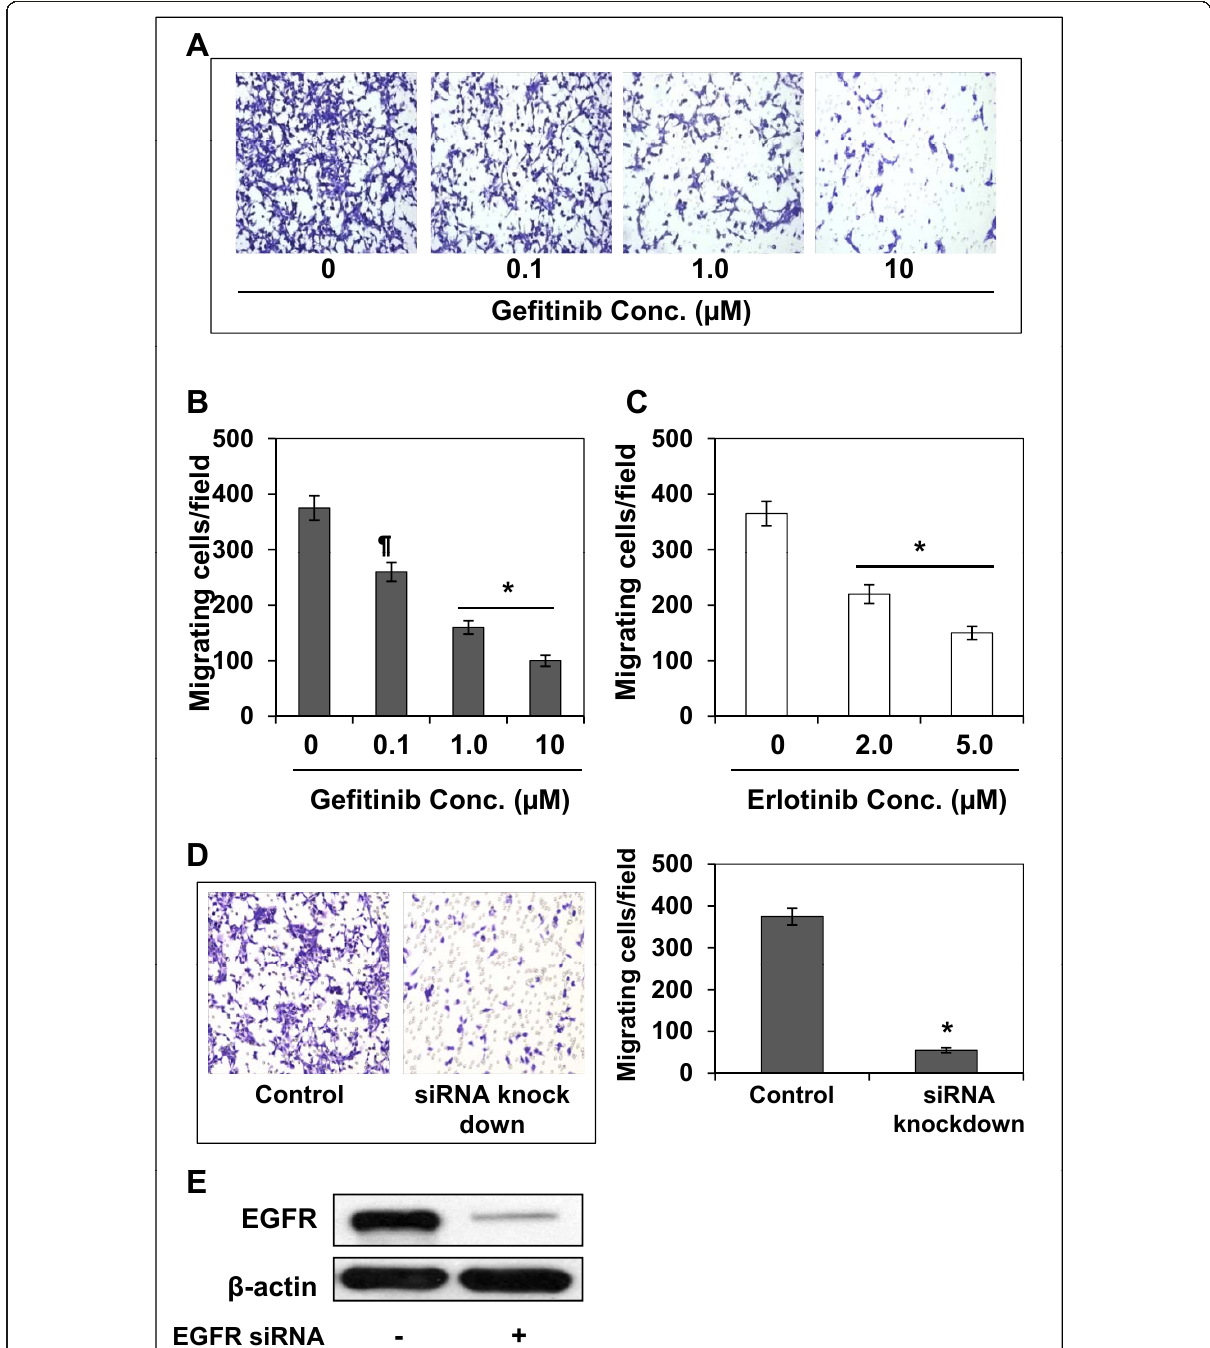
Figure 3 Effect of gefitinib, an inhibitor of EGFR, on SCC13 cell invasion . (A) Treatment of human head and neck cutaneous squamous cell carcinoma cells with gefitinib, a small molecule inhibitor of EGFR, for 12 h inhibits invasion of cells in a concentration-dependent manner. (B) The invasive cells were counted and the results expressed as the mean number of invasive cells ± SD per microscopic field. (C) Treatment of SCC13 cells with erlotinib, an inhibitor of EGFR, inhibited cell invasion. Significant reduction of cell invasion versus untreated control cells, ¶ P < 0.05, * P < 0.001. (D) Transfection of cells with EGFR-siRNA significantly decreases cell invasion. SCC13 cells were transfected with EGFR-siRNA to knockdown EGFR expression (left panel). Significant reduction of cell invasion versus control siRNA-treated cells, * P < 0.001 (right panel). (E) Western blot analysis revealed that transfection of SCC13 cells with EGFR-siRNA resulted in marked reduction in the levels of EGFR in